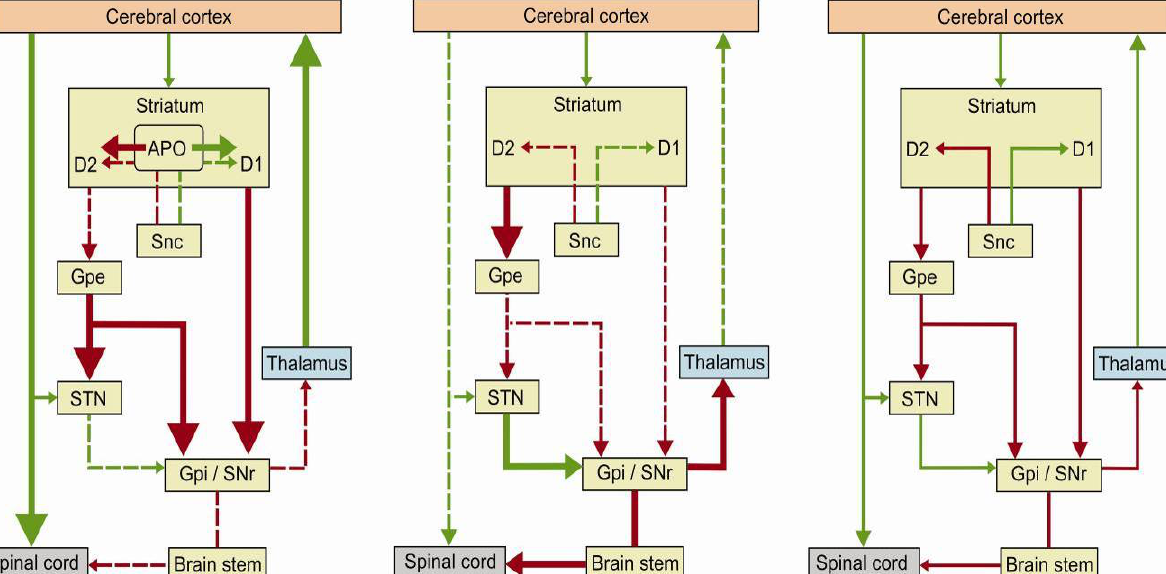
APO medication (left); in untreated PD patients (center) and in healthy subjects (right) [10,18]. The green lines denote excitatory pathways; the red lines denote inhibitory pathways. A thick line denotes increased activity and a dotted line denotes a decreased activity. APO , D (D and D -like dopaminergic receptors); Gpe (external segment of (apomorphine); D 2 1 1 2 globus pallidus); Gpi (internal segment of globus pallidus); Snc (compact segment of substantia nigra); SNr (reticular segment of substantia nigra); STN (subthalamic